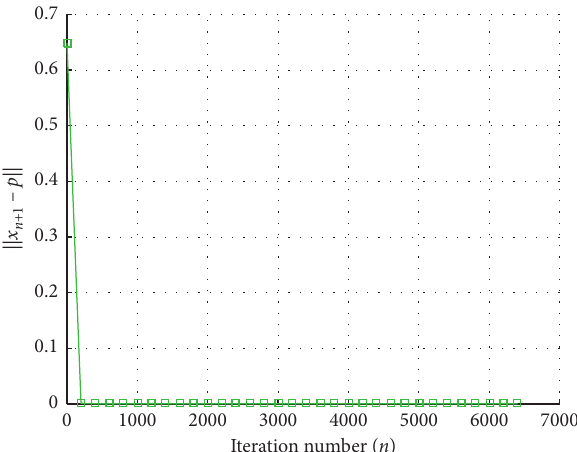
Figure 3: Graph of ‖ x